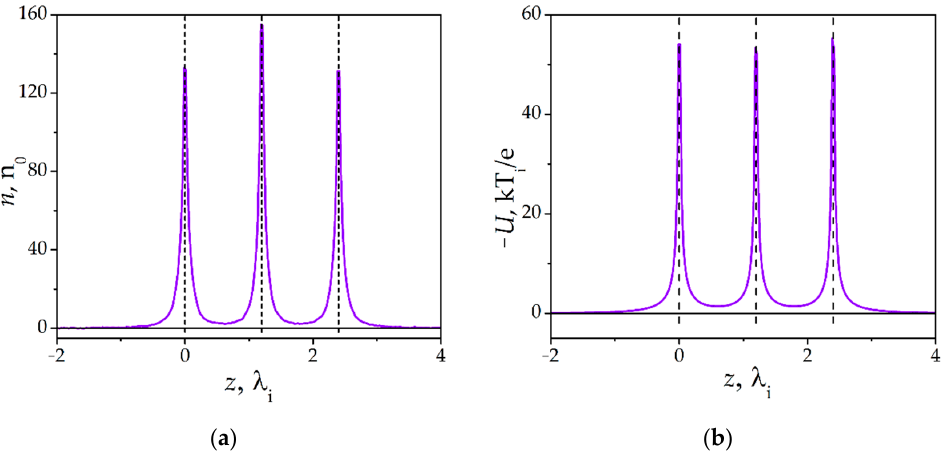
Figure 2. Self-consistent spatial distributions of the ( a ) space charge n ( ρ = 0, z ) and ( b ) plasma potential U ( ρ = 0, z ). F ext = − 0.2, l i = 5, E = 0.